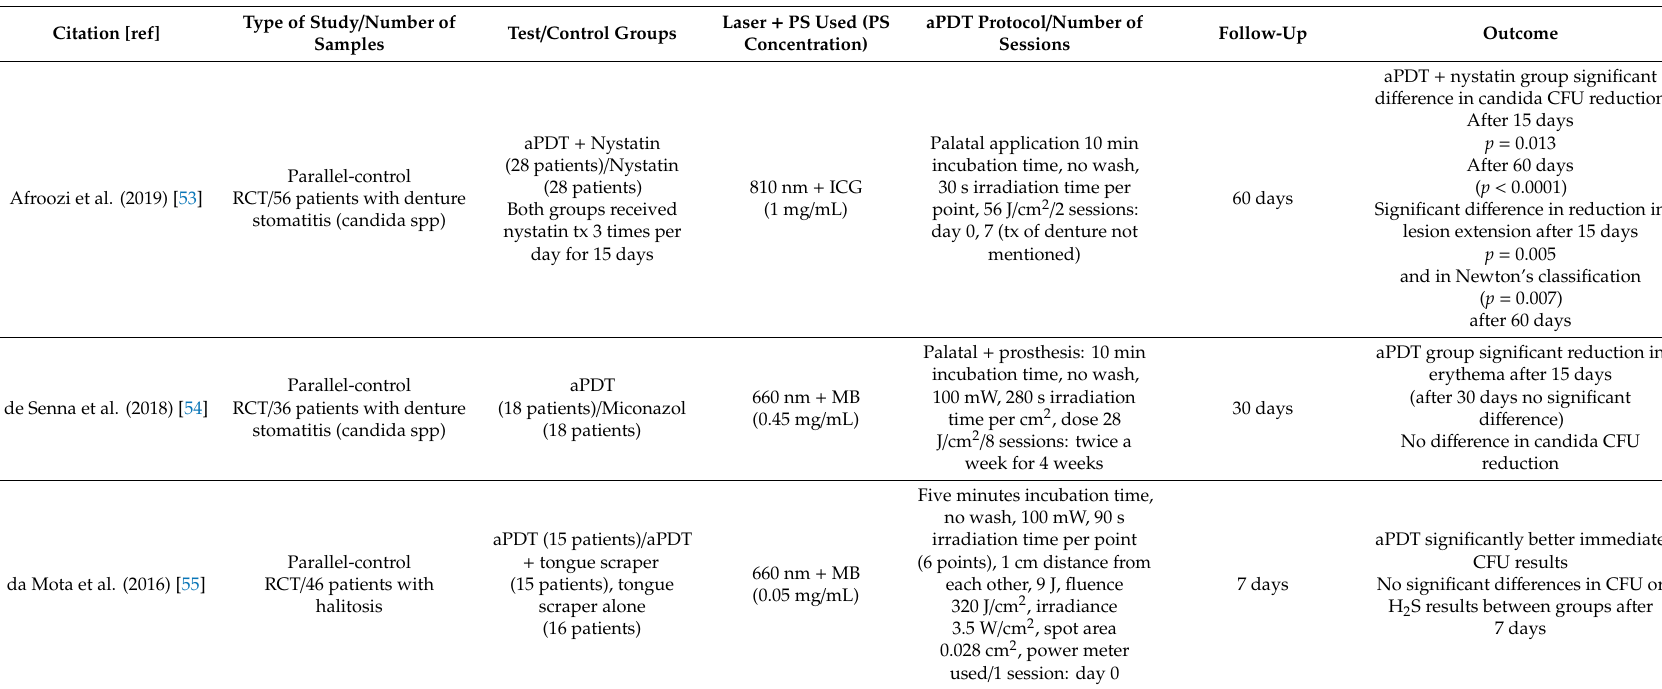
Table 5. Studies with aPDT on Candida and